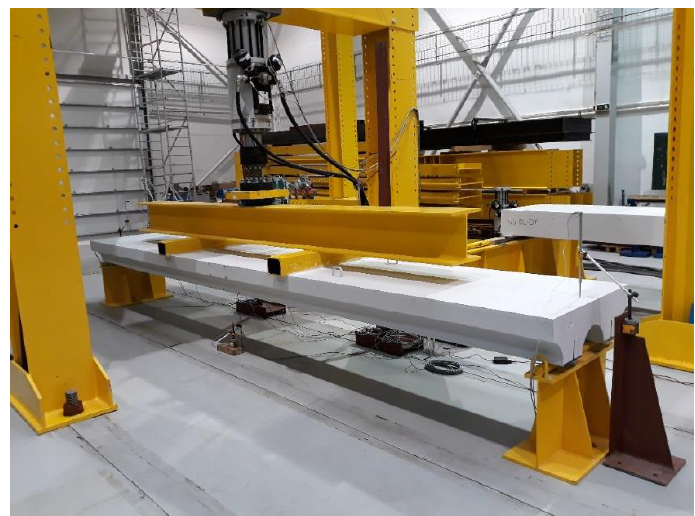
Fig. 5. Loading test being performed on the specimen.